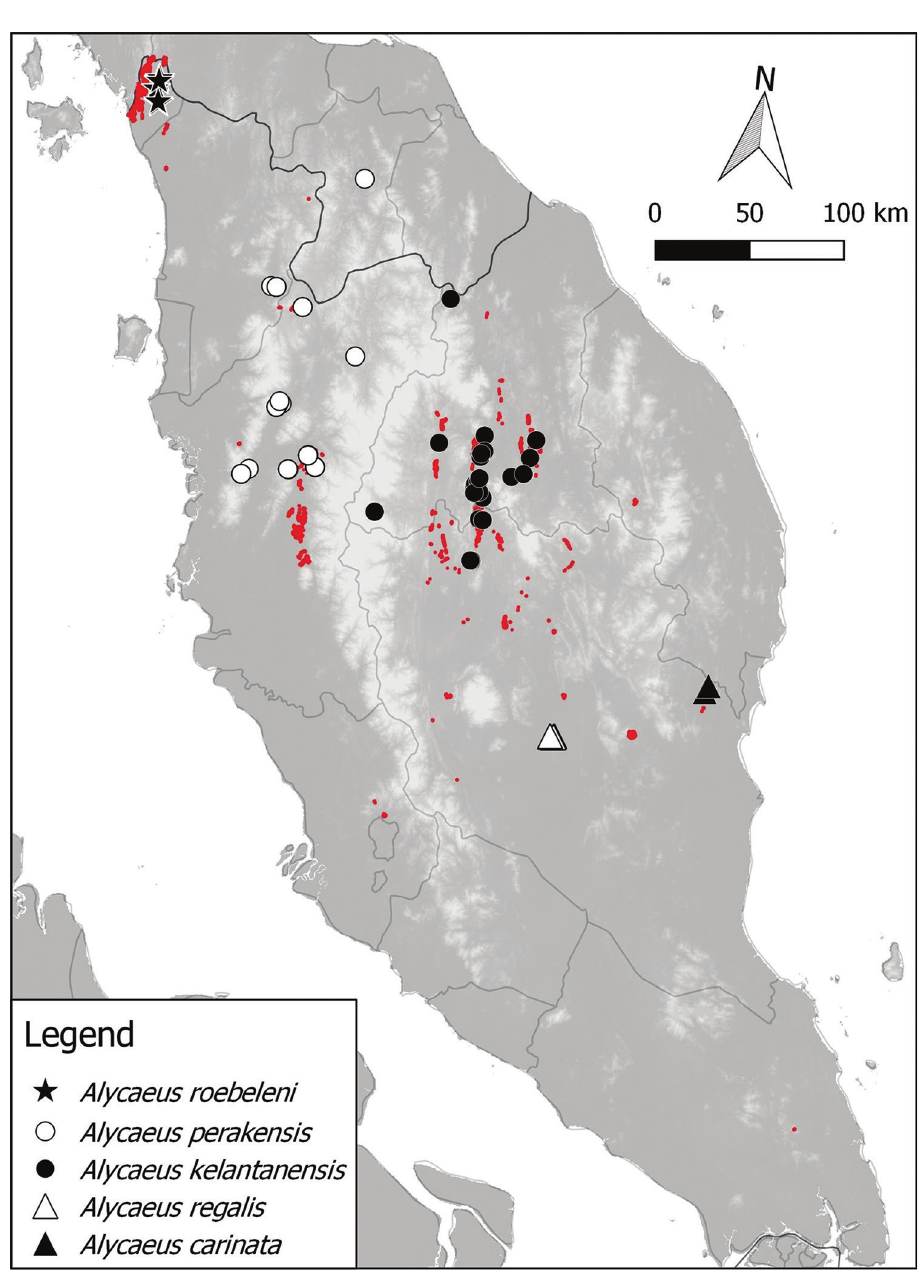
Figure 6. Distribution of 5 Alycaeus species in Peninsular Malaysia based on materials examined. Note that two records of Alycaeus roebeleni in Thailand, north of Peninsular Malaysia are not shown in the map. The red areas are limestone karsts (derived from Liew et al.